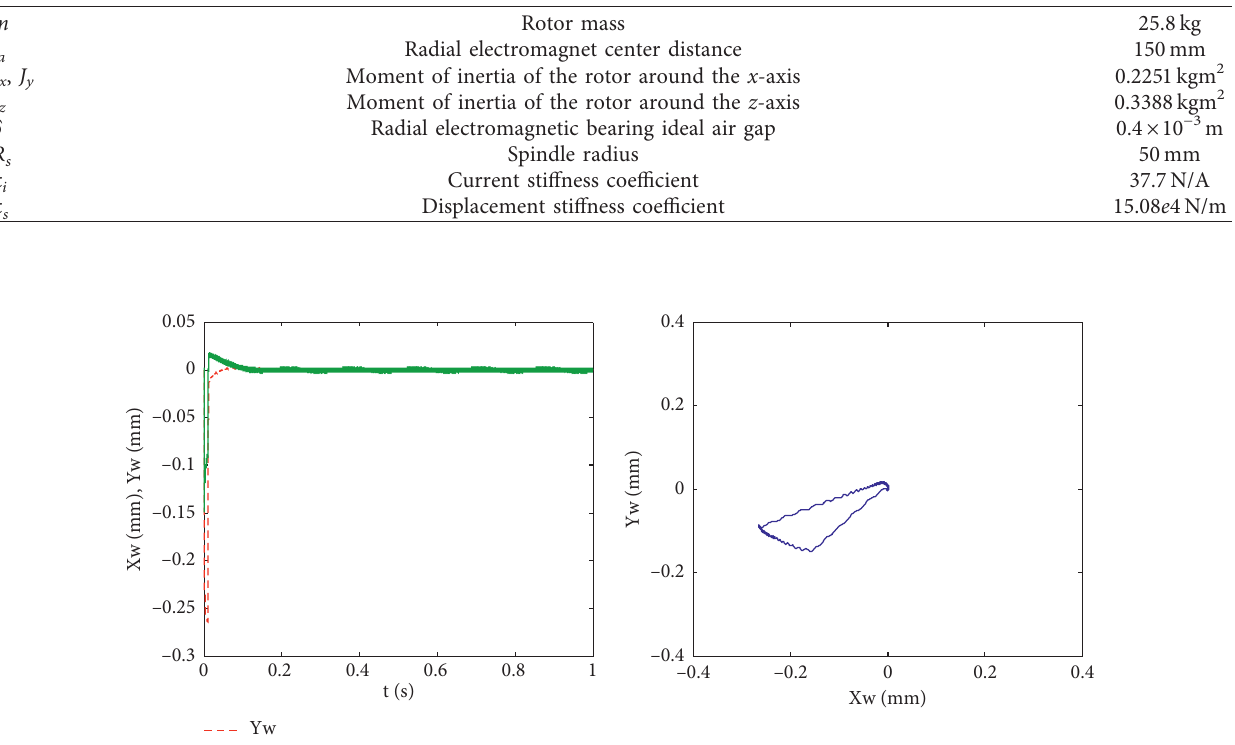
Table 1: Electric spindle parameters.